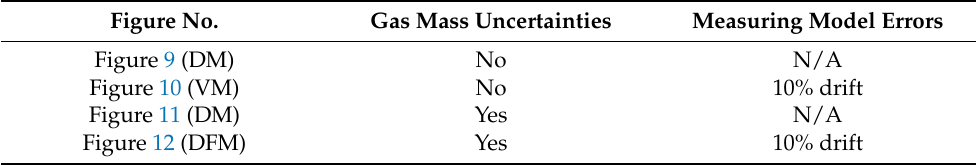
Table 1. Uncertainty combinations for figures. Figure No.